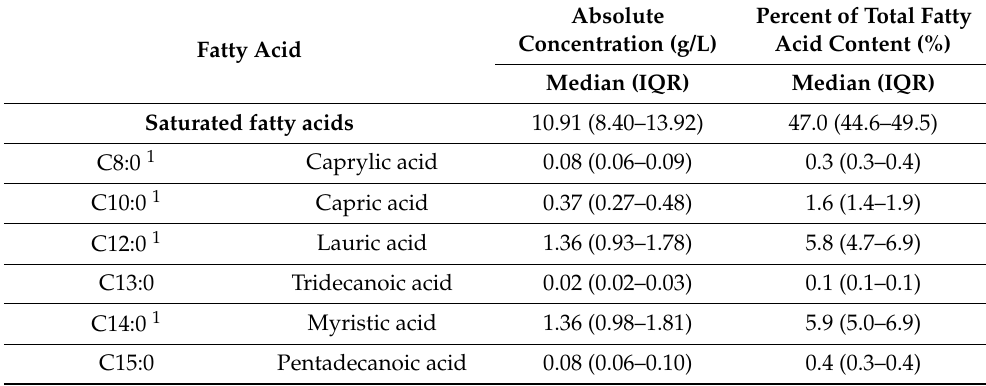
Table 3. Concentrations and percentages of fatty acids in milk ( n =